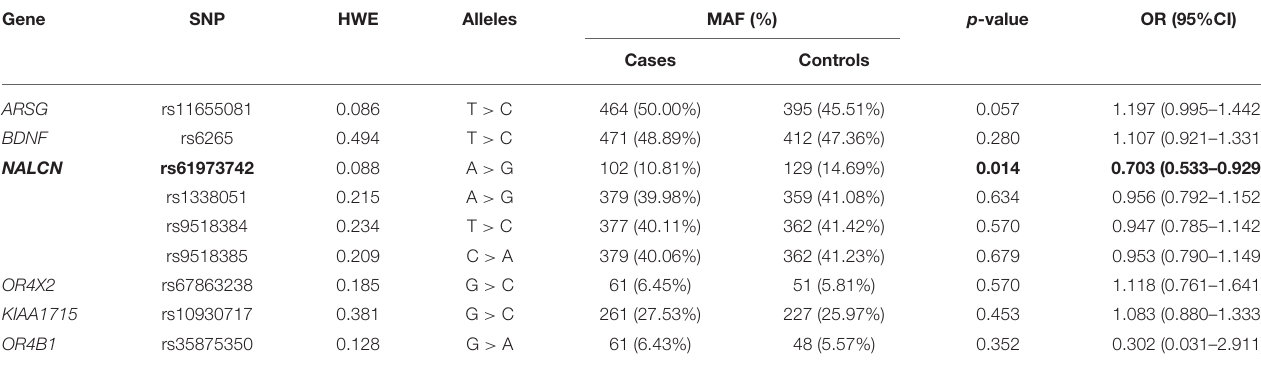
TABLE 2 | Allele frequency of patients with PD and healthy controls.